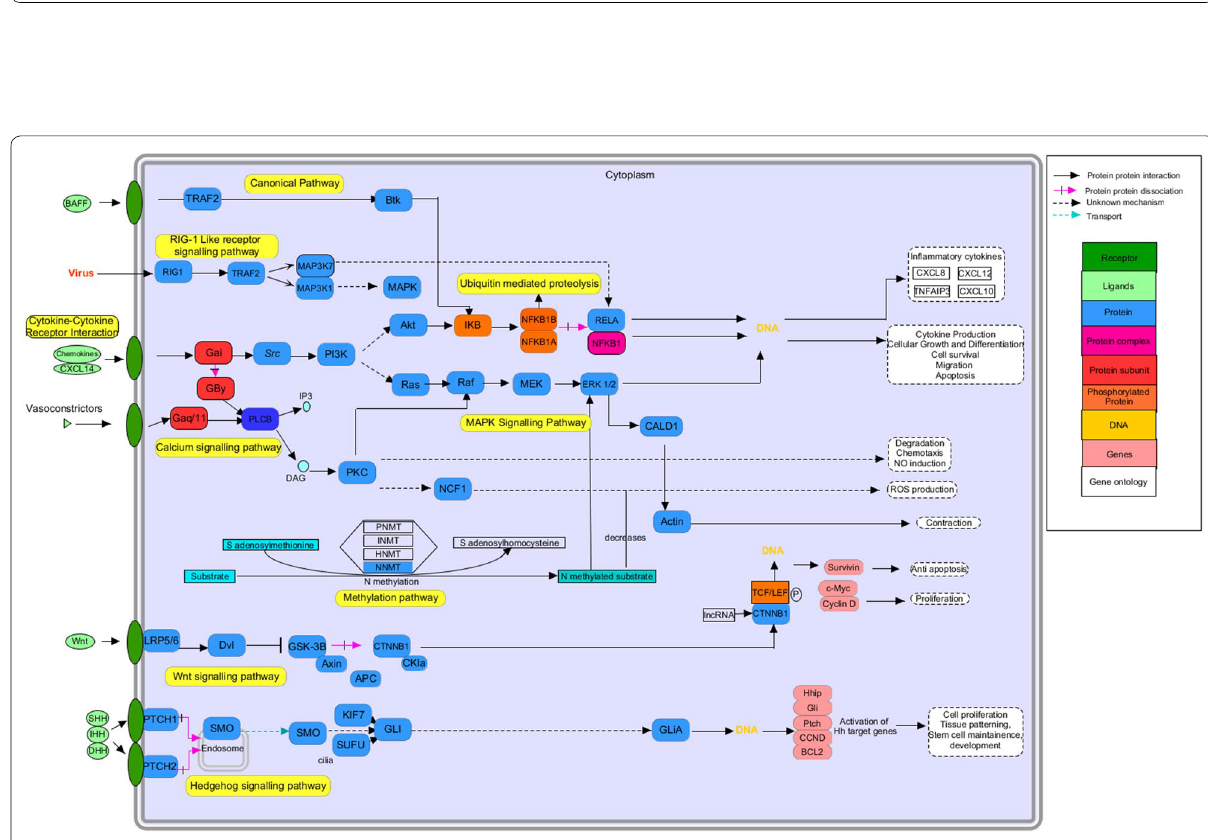
Fig. 5 A genetic network of a total number of gene signatures associated with CRC differentially expressed seeder genes. Red nodes represent CRC seeder genes, blue nodes showing signature genes associated with seeder genes having no role in CRC while pink nodes represent gene signatures associated with seeder genes having a role in CRC